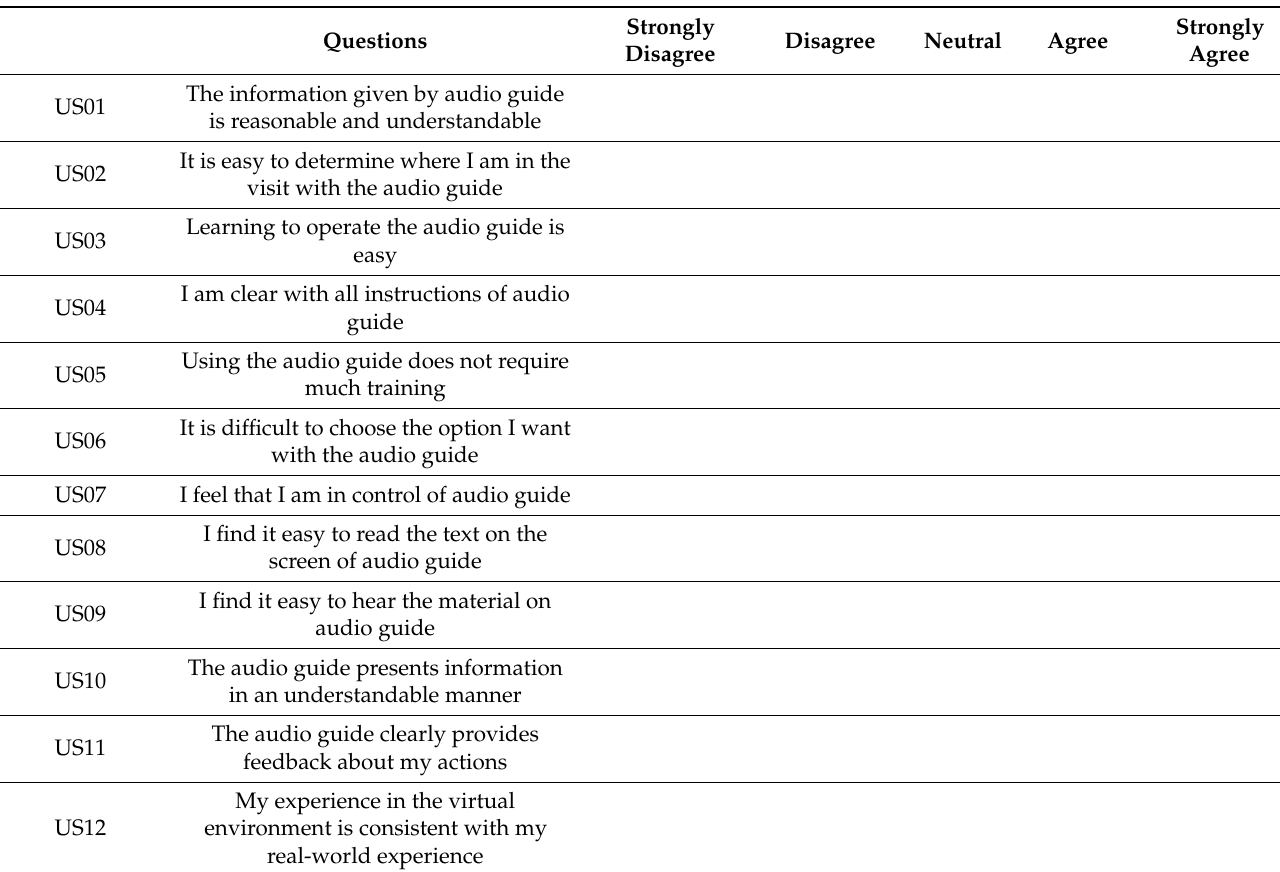
Table A1. Questionnaires for Audio Guide (English